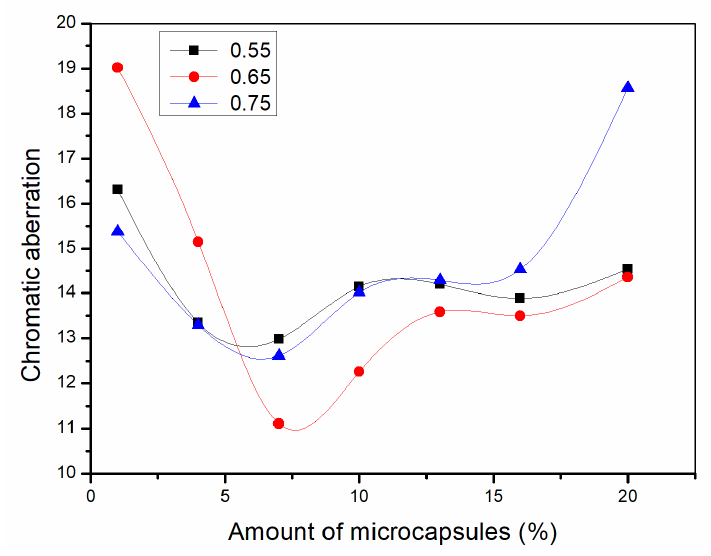
Figure 14. Chromatic aberration of the coating after drying at 160 °C for 2 h.